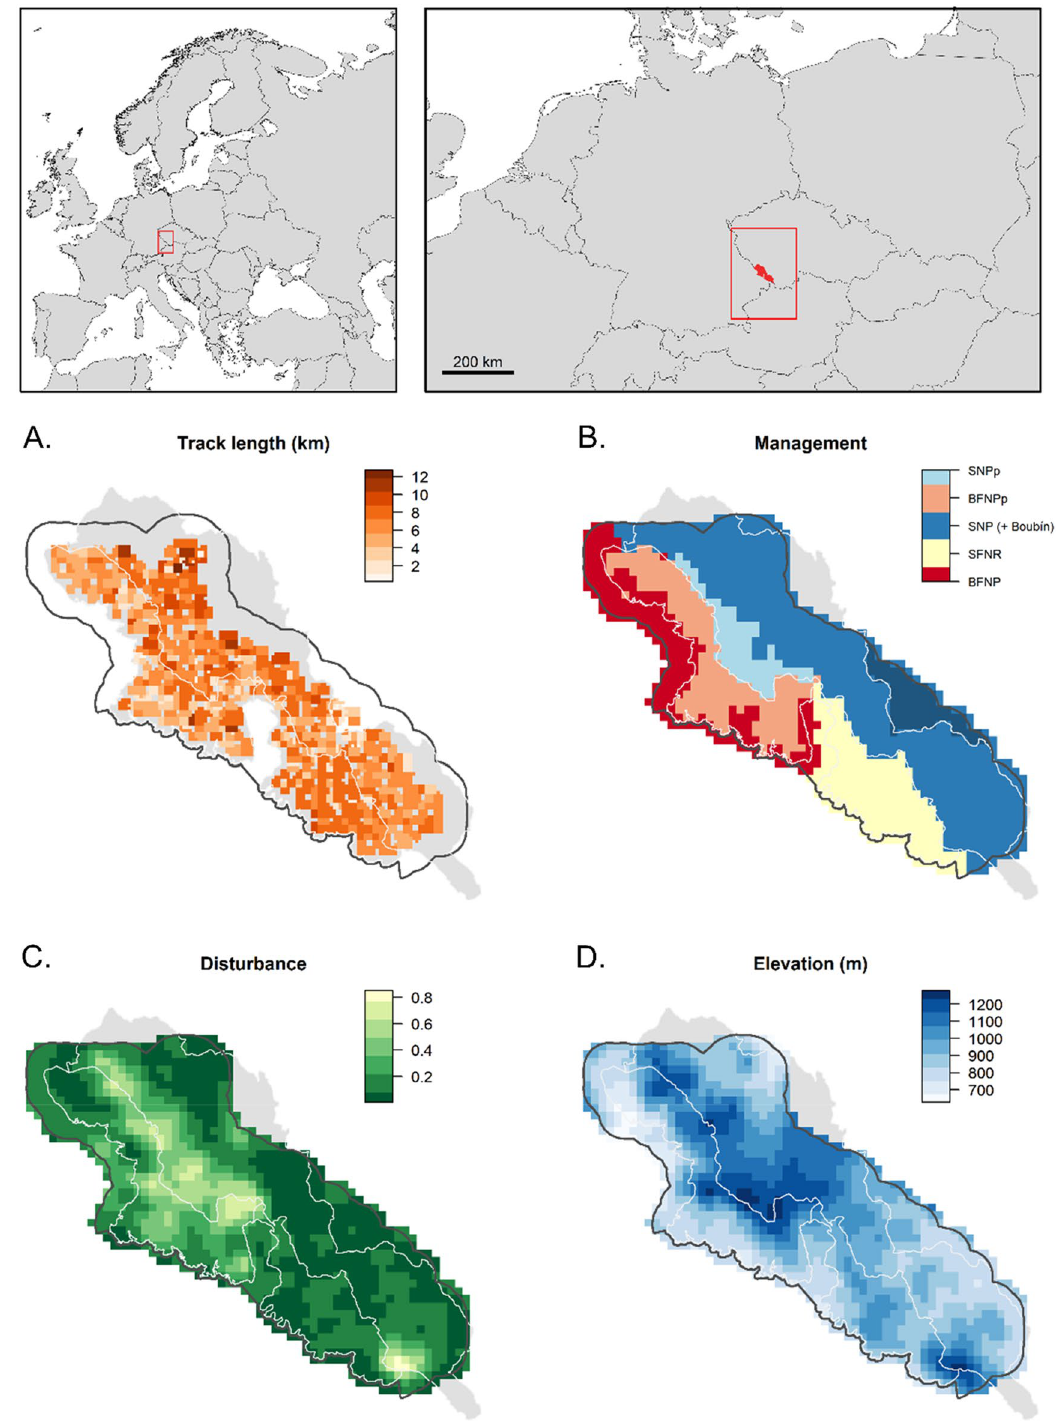
Figure 1. Spatial covariates included to model variation in red deer detection probability ( A recorded GPS search tracks) and density ( B management units, C elevation, D proportion of forest disturbances). The management units in the panel B are: (1) BFNPp: the no-hunting zone of the Bavarian Forest National Park, (2) BFNP: ungulate management zone of the Bavarian Forest National Park, (3) SFNR: the State Forest Neureichenau district, (4) SNPp: the no-hunting zone of Šumava National Park, and (5) SNP: the ungulate management zone of the Šumava National Park and a small part of the State Forest district Boubín in the buffer of the central part of the study area on the Czech side (darker blue area outside the white lines). For visibility, soft edges of the management units are not shown. White and black lines show the three administrative units and the border of the study area used in the spatial capture-recapture analysis, respectively. The inset maps in the top row show the location of the study area (red rectangle) within the mainland Europe. All maps were created using R 59